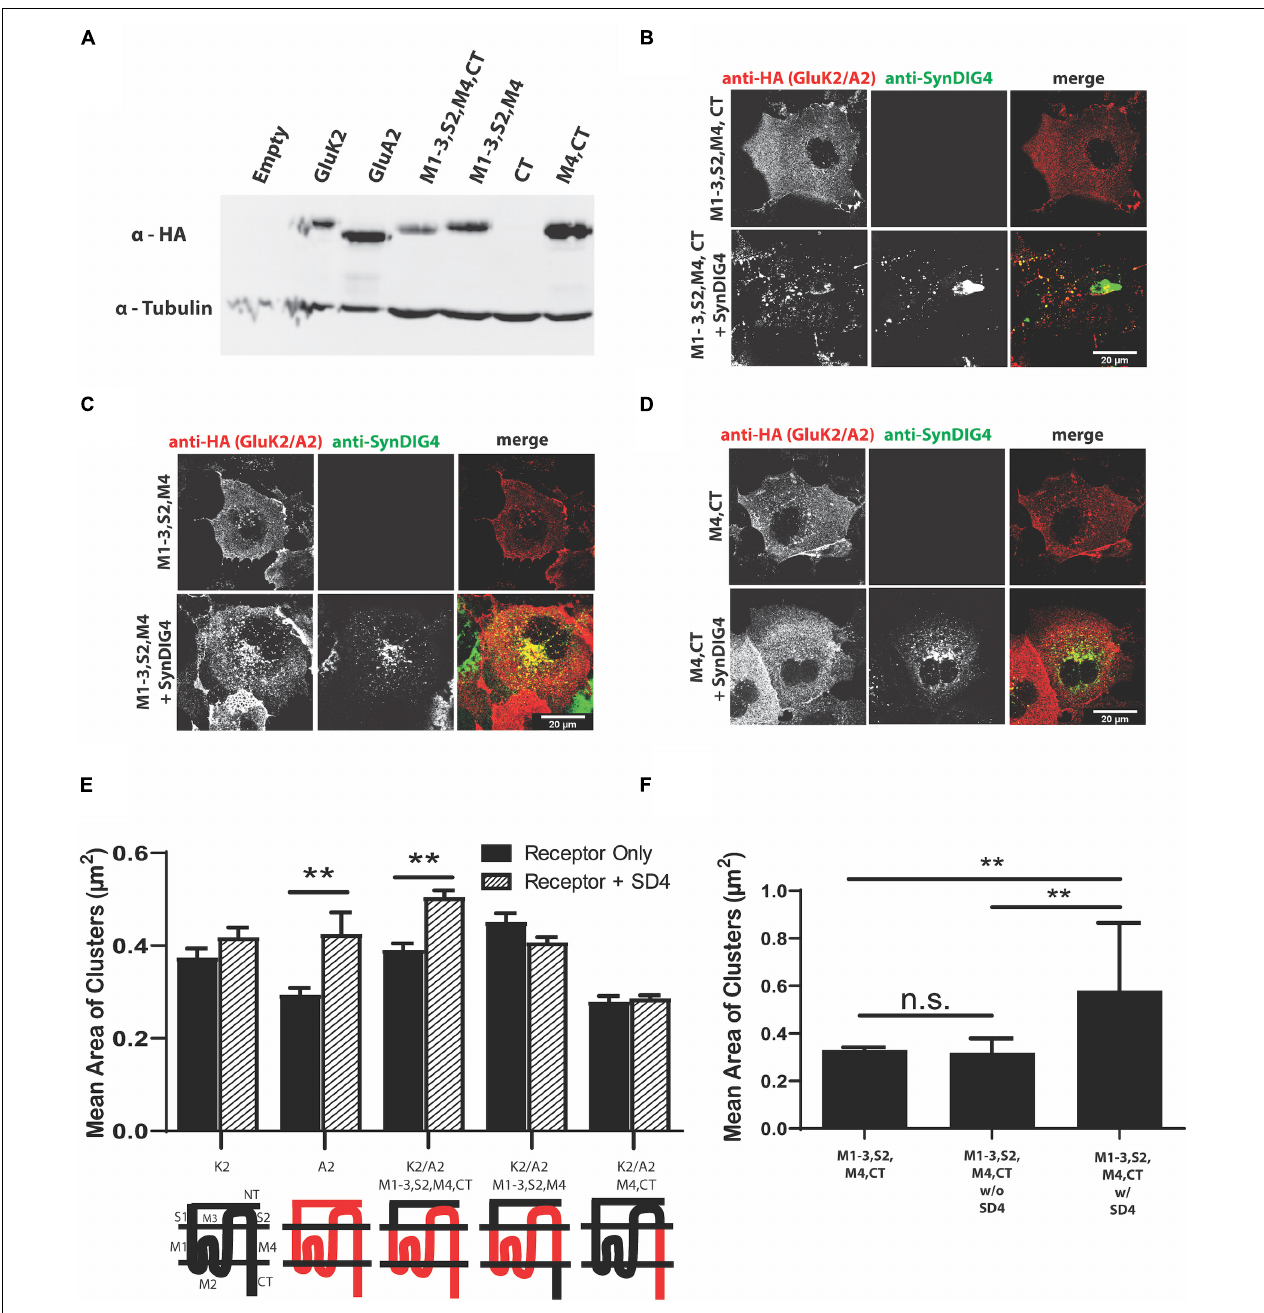
FIGURE 4 | The N-terminus of GluA2 is dispensable for clustering with SD4. (A) Immunoblot depicting expression of GluK2/GluA2 chimeras. Homologous domains of GluA2 were inserted into the backbone of GluK2 (as shown in Table 3 of Methods). β -tubulin was used as the loading control. (B–D) Representative confocal images of COS cells transfected with either a GluK2/A2 chimeric receptor alone, or co-transfected with SD4. Scale bar = 20 µ m. (E) Graph depicts the mean area of clusters when GluK2, GluA2, and each GluK2/A2 chimera is expressed either alone or co-expressed with SD4. (F) Graph depicts mean the area of M1-3, S2, M4, CT chimera clusters stratified for either co-localized or non-colocalized with SD4. M1-3, S2, M4, CT alone ( n = 14), M1-3, S2, M4, CT w/o SD4 ( n = 11), M1-3, S2, M4, CT w/ SD4 ( n = 13). Data are represented as mean ± SEM; n.s. not significant; ** p < 0.01; one-way ANOVA with post-hoc Tukey’s test.